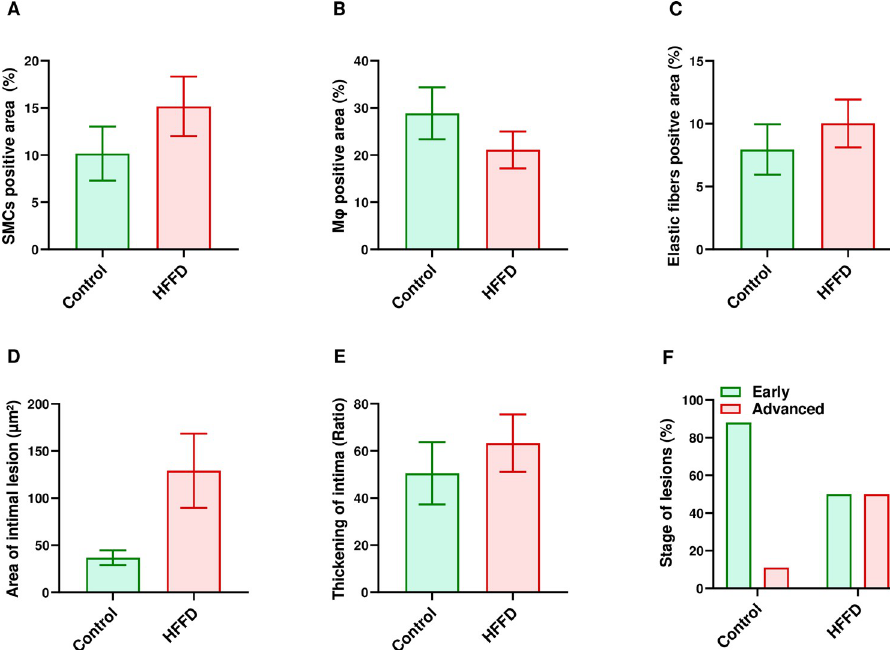
Fig 4. Quantification of aortic atherosclerosis following 12 weeks of HFFD feeding. Positively immuno-stained area of: (A) SMCs (detected using an anti-HHF35 antibody), (B) M φ (detected using an anti-RAM11 antibody) and (C) elastic fibers (detected using the Orceine stain), were quantified using an image analysis system as described in the method. The same image analysis system was used to determine, (D) the intimal lesion area. Whereas, (E) the thickening of intima was determined by dividing the area of intimal lesion by the length of media. (F) Plaques were classified into early (type II and III plaques) and advanced (type IV and V plaques) stage lesions. Data in all graphs are represented as the mean ± SEM except for the stage of lesions, which was expressed in percentages. Statistical analysis was performed using one-way Anova for all parameters except for stage of lesions, for which a Chi square test was used (n = 9 for Control and n = 12 for